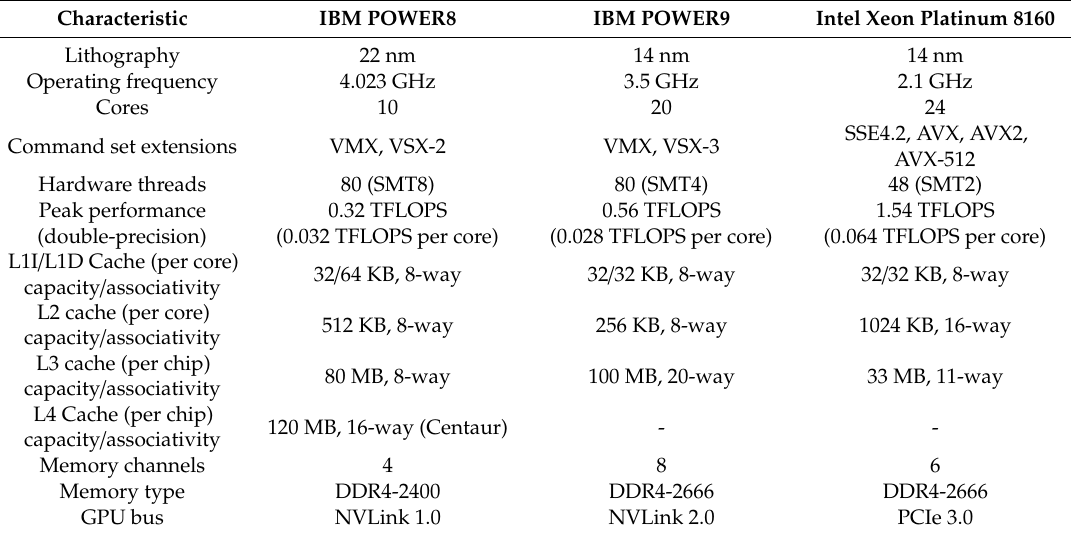
Table 1. Key characteristics of computing systems’ CPUs.